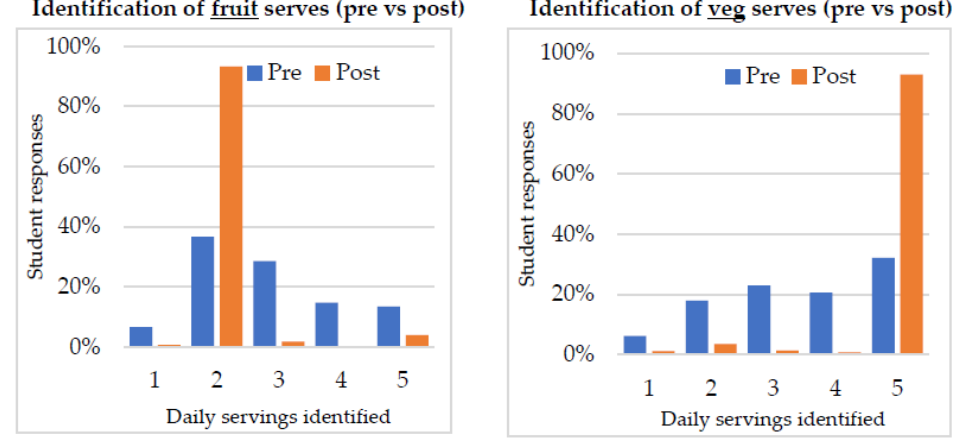
Figure 1. Student responses for recommended number of serves of fruit and veg. per day.